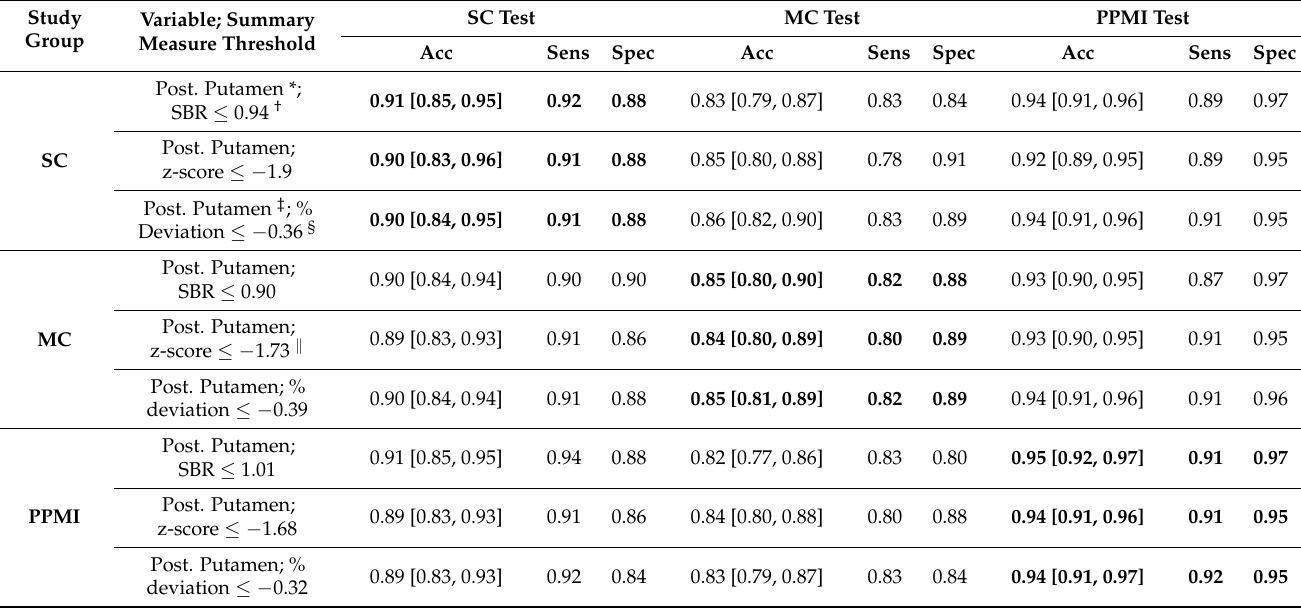
Table 4. Cross-group single variable